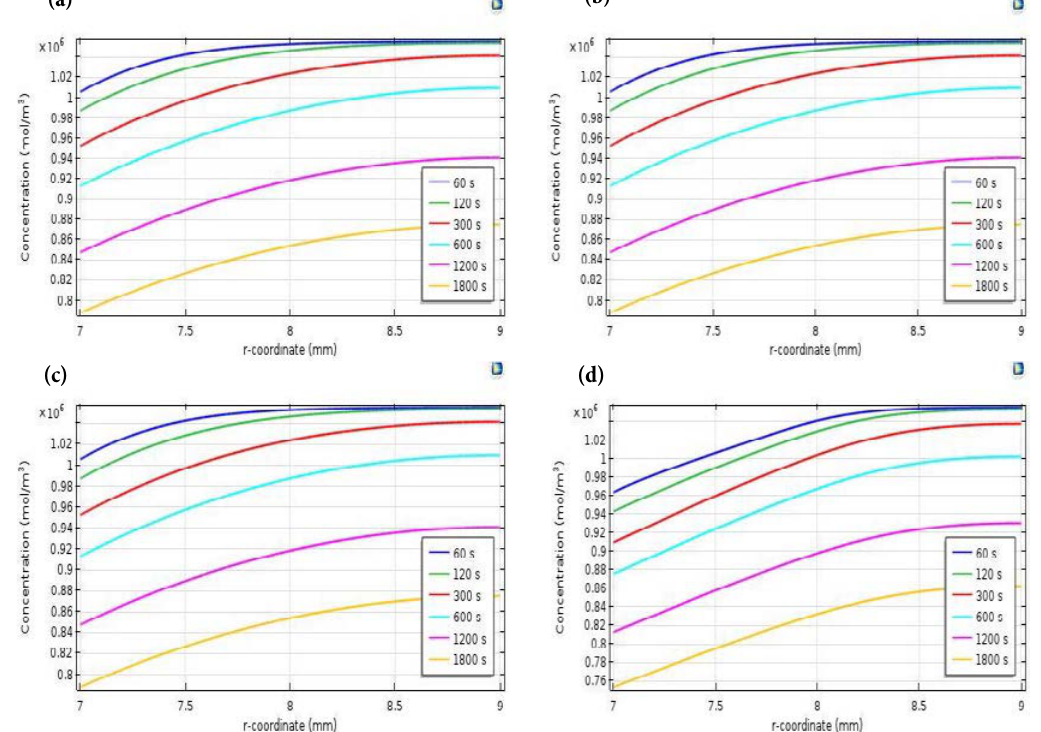
Fig. 9: Concentration distribution of water in feed phase vs. radius at various membrane lengths (0.5 l/min feed flow rate and 30°C temperature); (a) 25 mm, (b) 50 mm, (c) 75 mm and (d) 100 mm